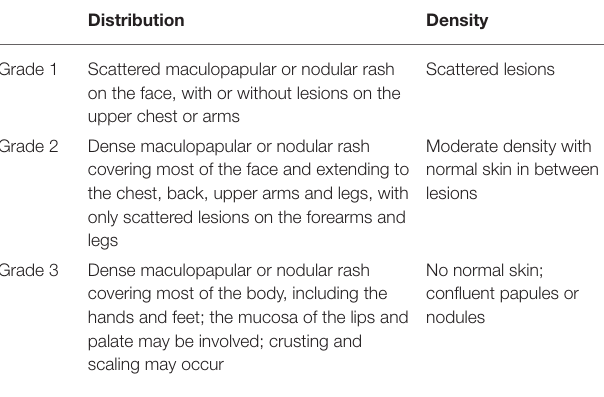
TABLE 1 | The PKDL grading system as reported from Sudan (Zijlstra et al., 2000; Zijlstra and el-Hassan, 2001). Distribution